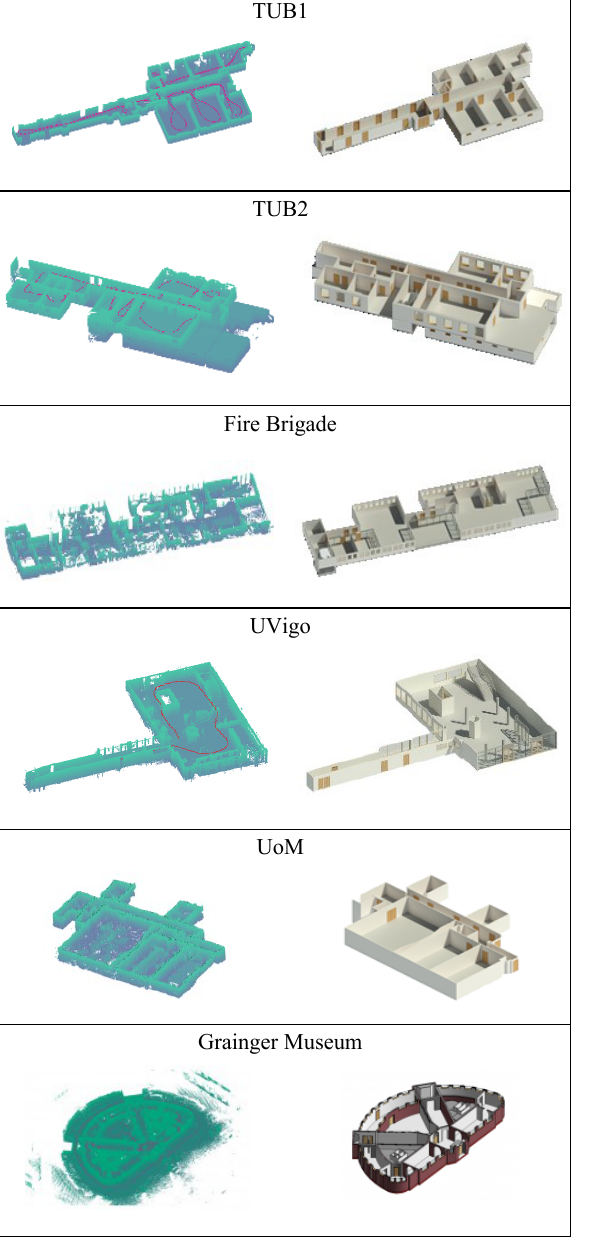
Figure 1. The benchmark point clouds (left) and the corresponding reference models